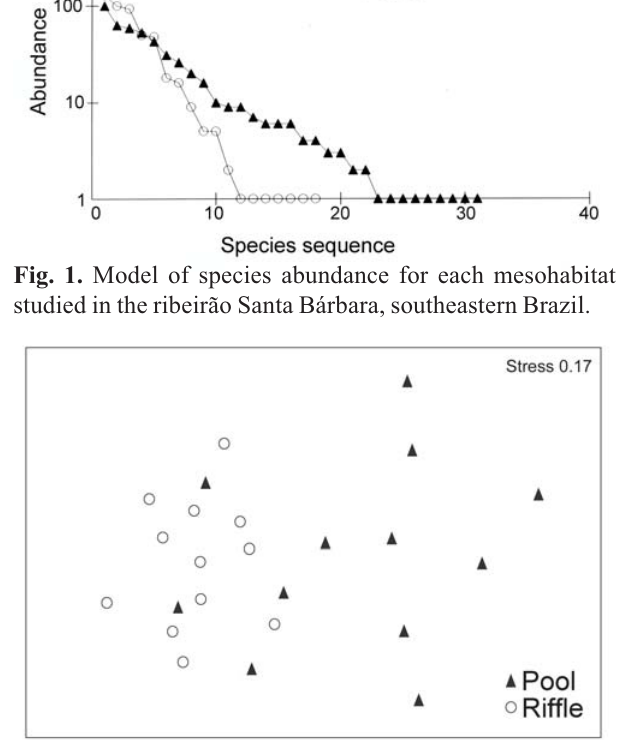
Fig. 2. Multidimensional scaling plot based on species abun- dance data in the riffle and pool reaches. Each symbol repre- sents a month.